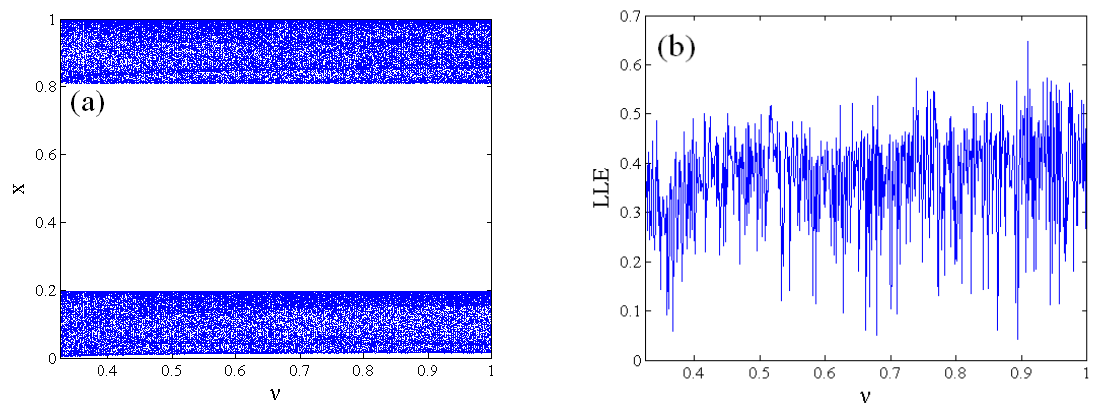
Figure 4. Bifurcation portrait and Lyapunov exponent spectrum with regard to ν . ( a ) Bifurcation portrait with regard to ν ; ( b ) Lyapunov exponent spectrum with regard to ν .